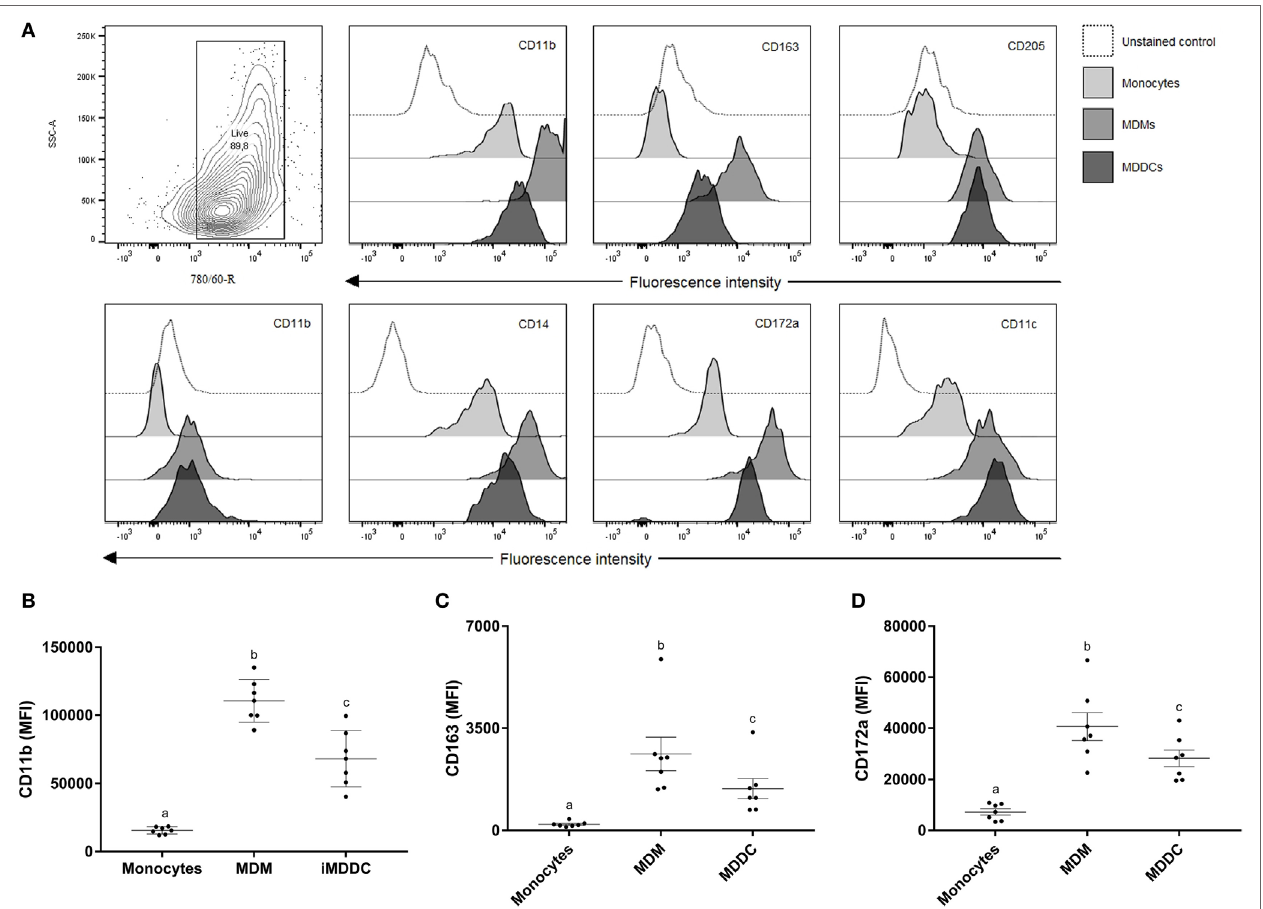
FigUre 2 | surface marker expression of cells from the MPs is heterogeneous . (a) Contour plot of live cell population and flow cytometry analysis of surface expression of CD11b, CD163, CD205, CD1b, CD14, CD172a, and CD11c on monocytes, monocyte-derived macrophages (MDMs), and monocyte-derived dendritic cells (MDDCs). CD11b, CD163, and CD172a are useful surface markers to distinguish MDMs from MDDCs (B–D) . Useful markers that distinguish MDMs from MDDCs include CD11b, CD163, and CD172a. Histograms of a representative animal are shown ( n = 7). Different letters indicate statistically significant difference ( p <